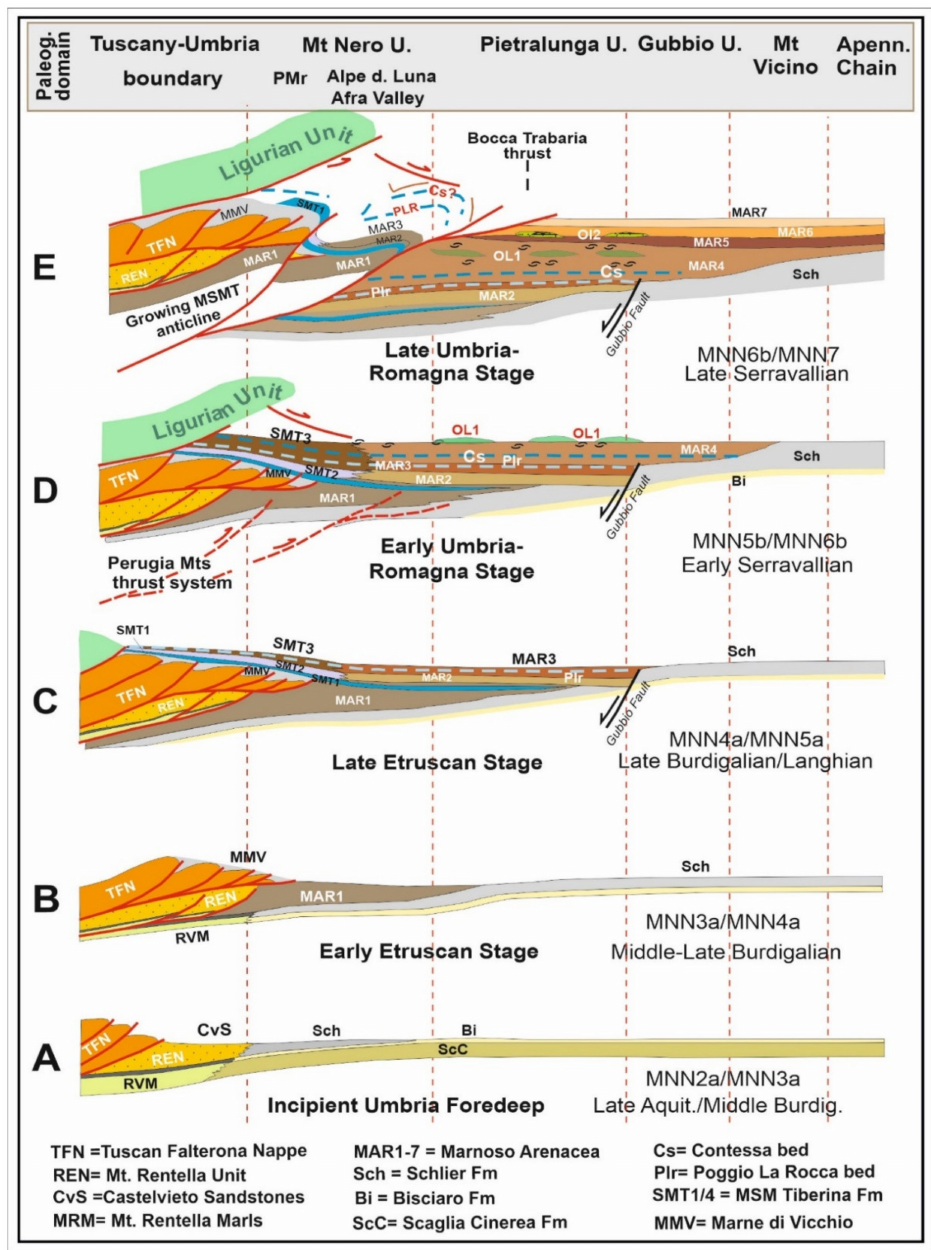
Figure 5. Exemplified tectono-sedimentary evolution of the Umbria pre-Apennines foreland basin system, during the Early and Middle Miocene; the stages, referred to the biozonation scheme proposed by [35–37] synthesized in Figure 2, are: ( A ) Incipient foredeep, ( B ) early Etruscan; ( C ) late Etruscan; ( D ) early Umbria-Romagna, and ( E ) late Umria Romagna stages (detail in the text; n.b.: sections are schematic and not in